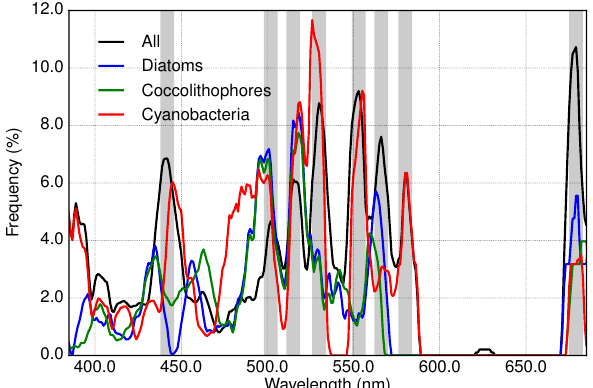
Figure 8. Spectral distribution of the frequency where the first derivatives of simulated R rs equal zero (a filter smooth window of 10 nm) calculated for all the scenarios (black); and cases of including only diatoms (blue), coccolithophores (green) or cyanobacteria (red) in the simulations. Chosen regions of high frequencies are